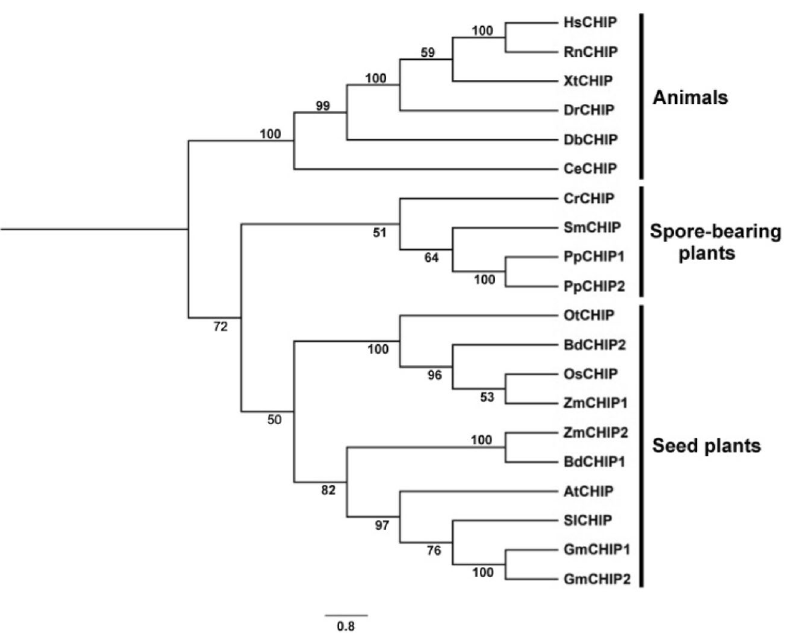
Figure 2. Phylogenetic analysis of CHIP homologs from different species. Twenty CHIP homologs with both TPR motifs and U-box domain from 16 animals and plant species were used in the construction of the phylogenetic tree. The rooted tree was generated with MEGA X v10.0.5 and FigTree v1.3.1 using Neighbor- Joining method with a p-distance model (1000 replicates). Numbers on the tree branches represent bootstrap